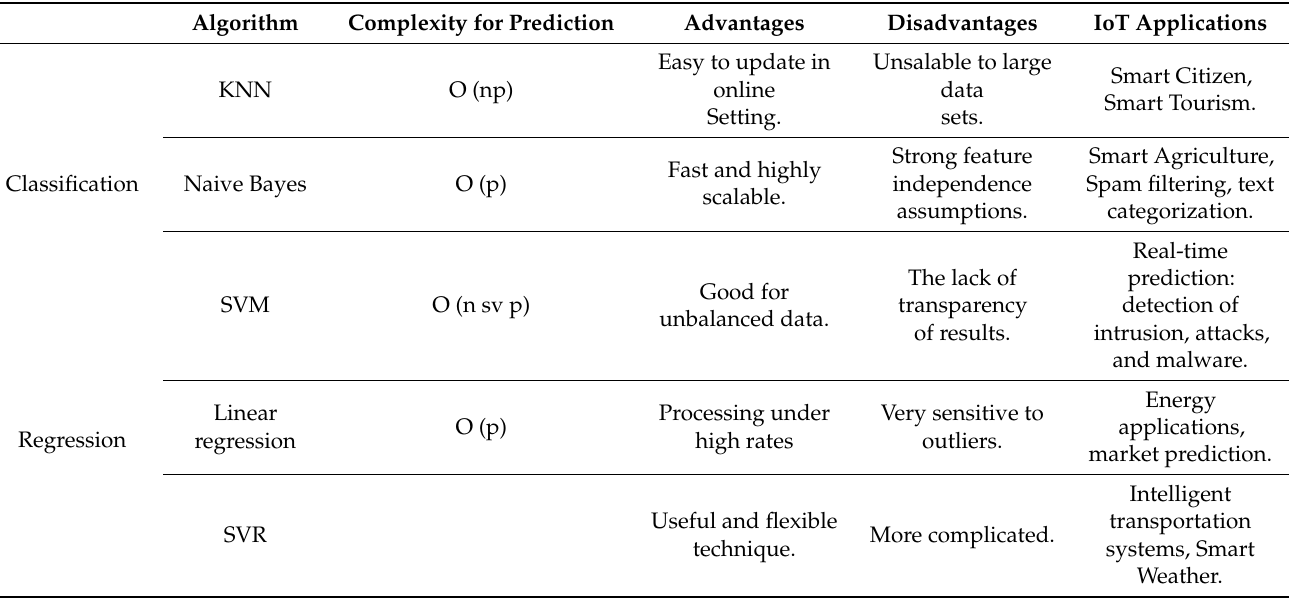
Table 11. Summary of Classification and Regression Methods.